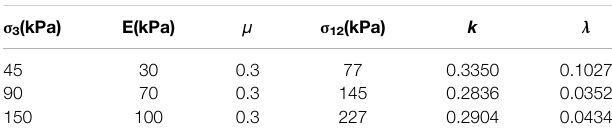
TABLE 3 | Model parameters in reference Meng et al., 2018.